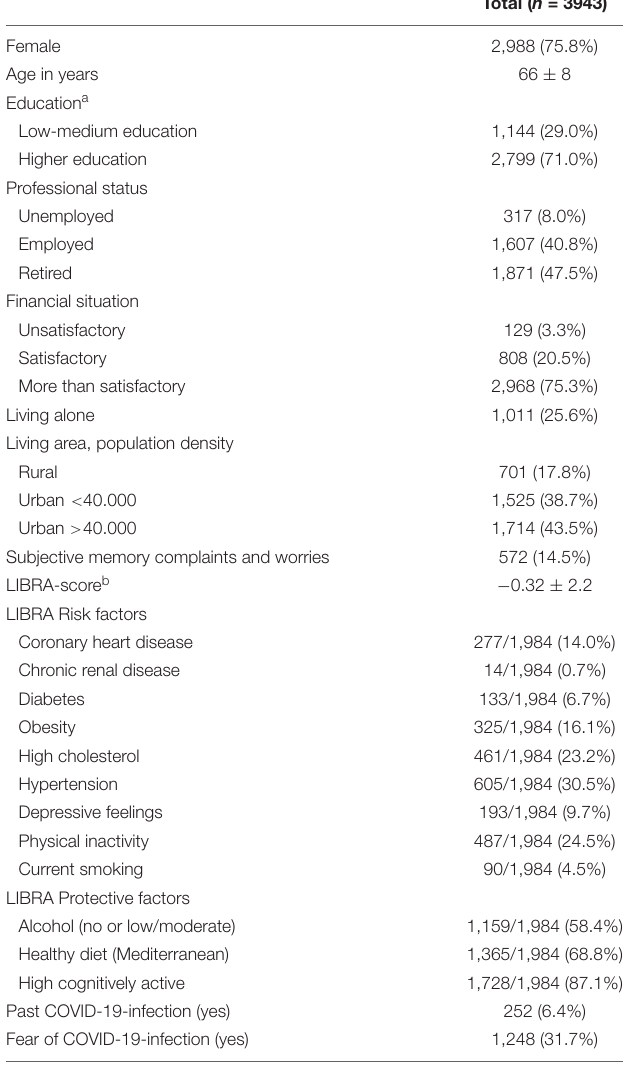
TABLE 1 | Participant